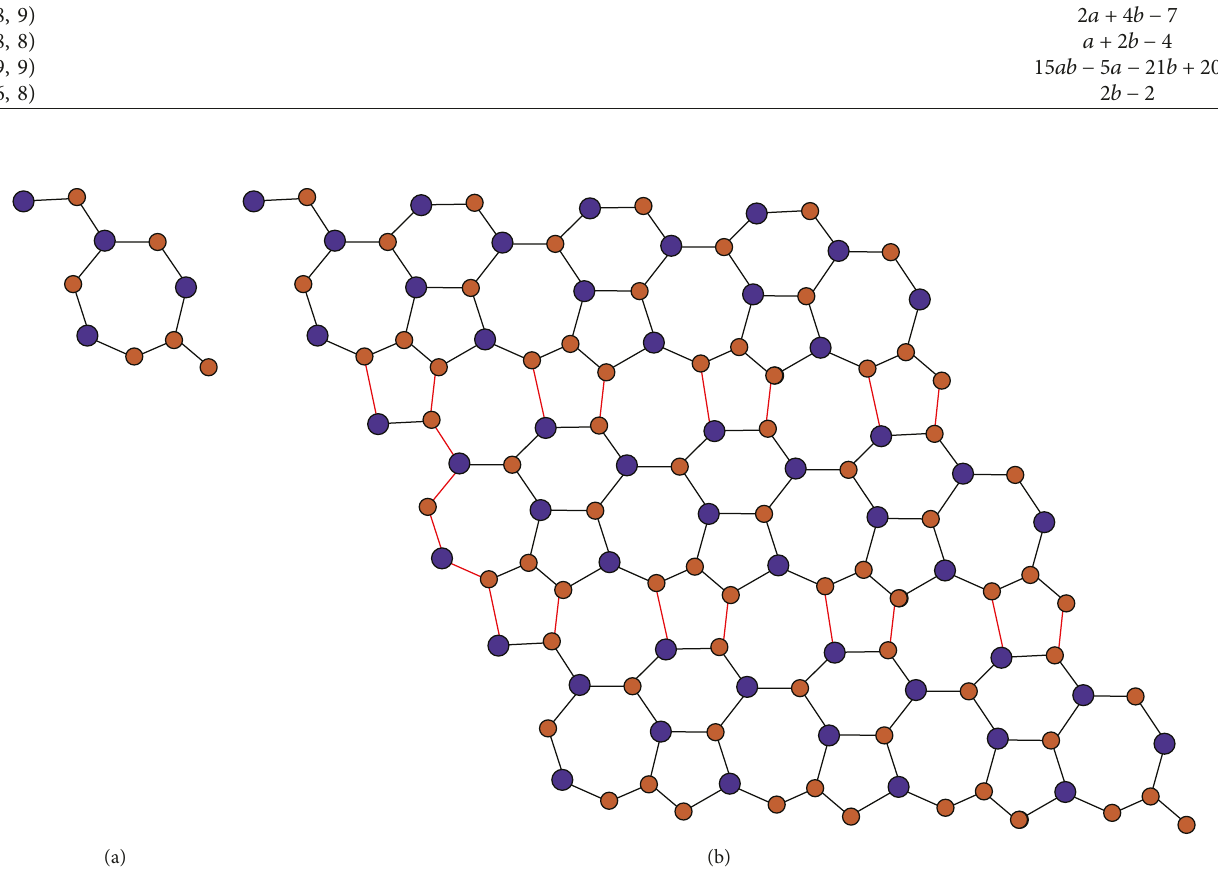
Figure 9: The unit cell and Si